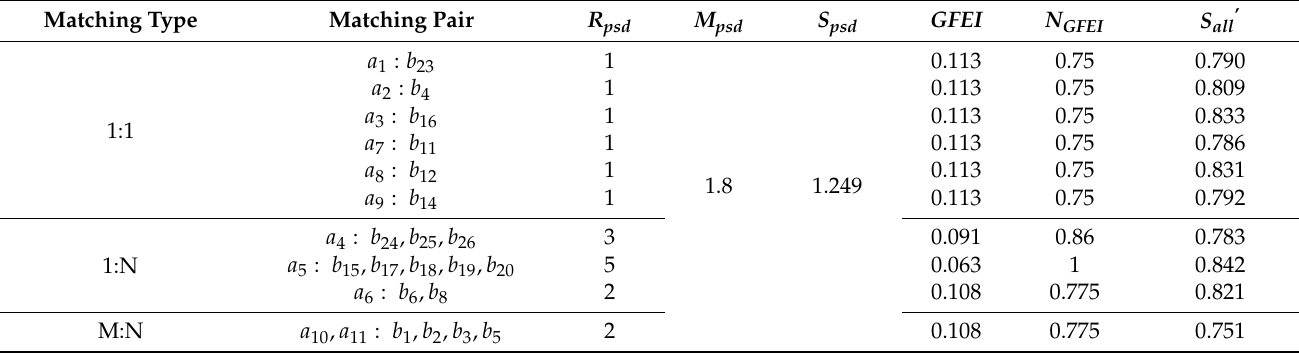
Table 2. Test results of GFEI. (where S all (cid:48) represents the total similarity values of the matching pairs after the 1:1 weighted